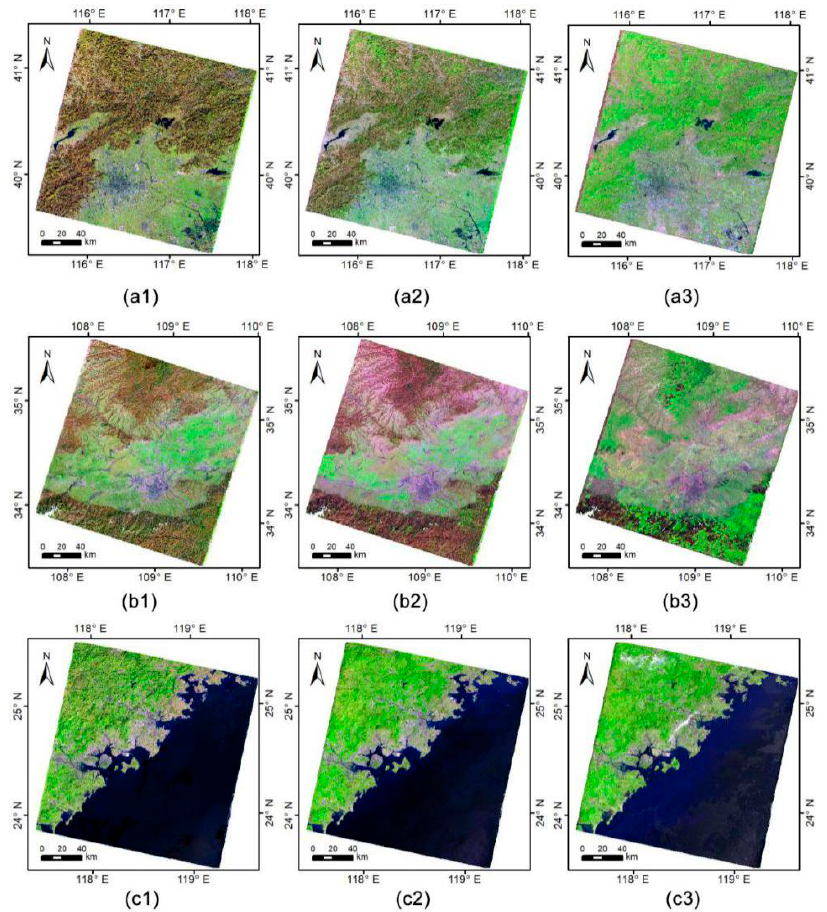
Figure 4. Annual composite images of the three districts obtained in this study (( a ), ( b ), and ( c ) repre- sent Beijing, Xi’an, and Xiamen, respectively; 1, 2, and 3 represent the results from ee.Reducer.min(), ee.Reducer.median(), and ee.Reducer.max() respectively). (R: Band 6; G: Band 5; B: Band 3).